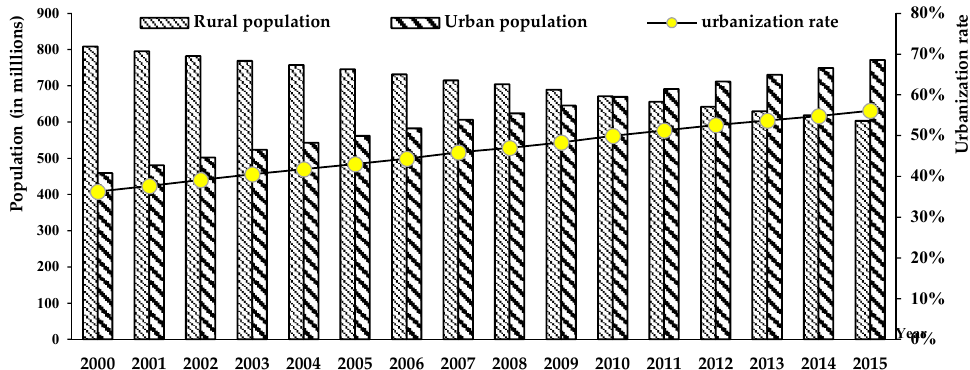
Figure 3. Population and urbanization rate of China from 2000–2015.